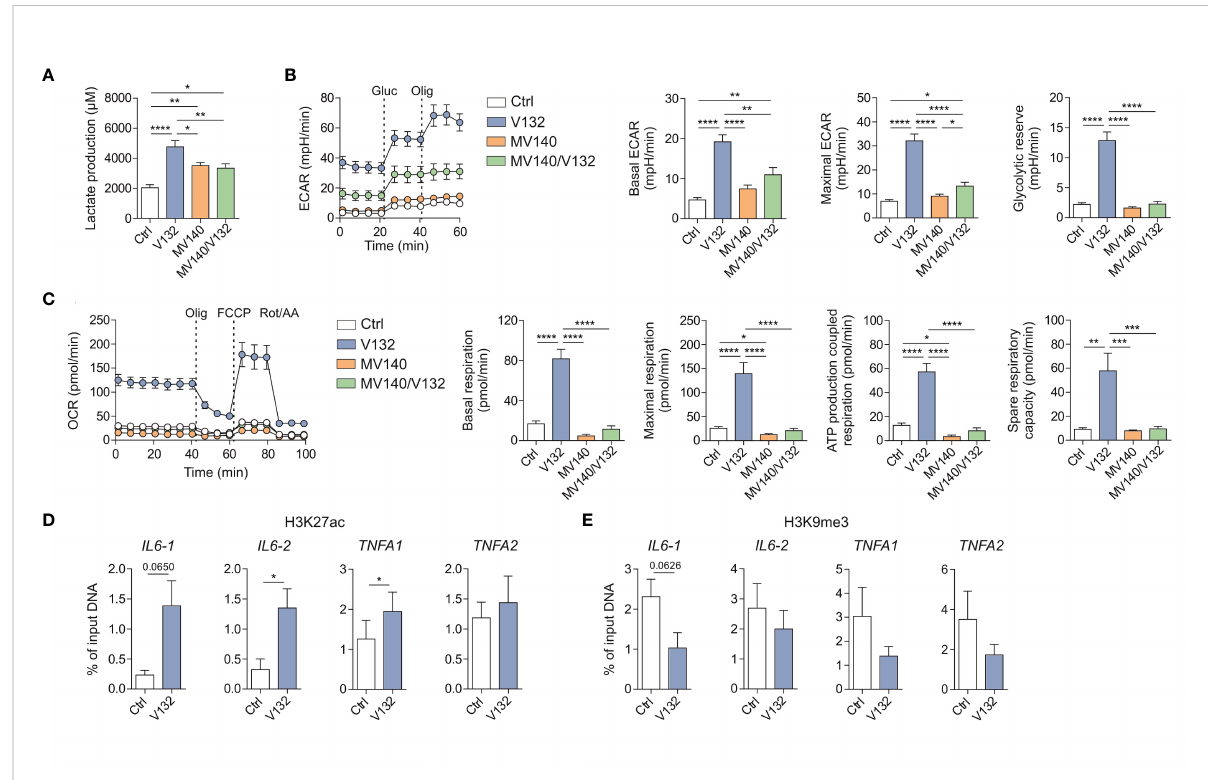
FIGURE 2 V132-trained cells exhibit metabolic and epigenetic rewiring. Human PBMC were incubated for 24 h with control excipients (ctrl), V132, MV140 or MV140/V132. On day 6 (prior to restimulation), metabolic and epigenetic assays were performed. (A) Lactate production by human PBMC was quanti fi ed (n = 12 donors offour independent experiments). (B) Kinetic study of extracellular acidi fi cation rate (ECAR) in ctrl-, V132-, MV140-, or MV140/V132-trained PBMC by sequential addition of glucose (Gluc) and oligomycin (Olig) (n = 7 donors of three independent experiments,